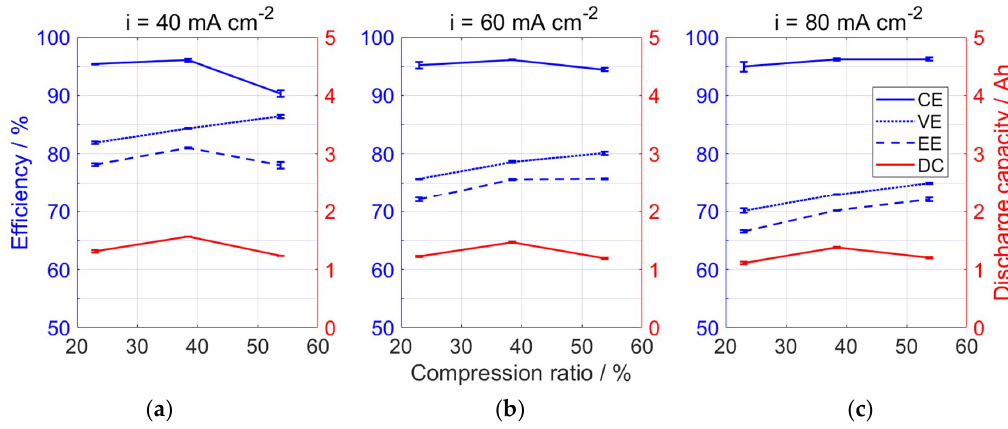
Figure 3. Effect of CR on the coulombic, voltage and energy efficiency and discharge capacity of the VRFB operating at 100 mL min −1 under various current density levels: ( a ) 40 mA cm −2 ; ( b ) 60 mA cm −2 ; ( c ) 80 mA cm −2.